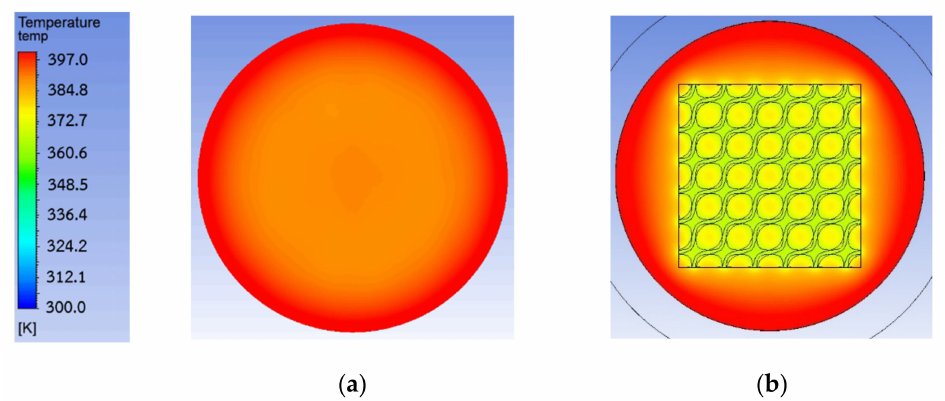
Figure 11. Temperature contour of membrane: ( a ) without TPMS; ( b ) with